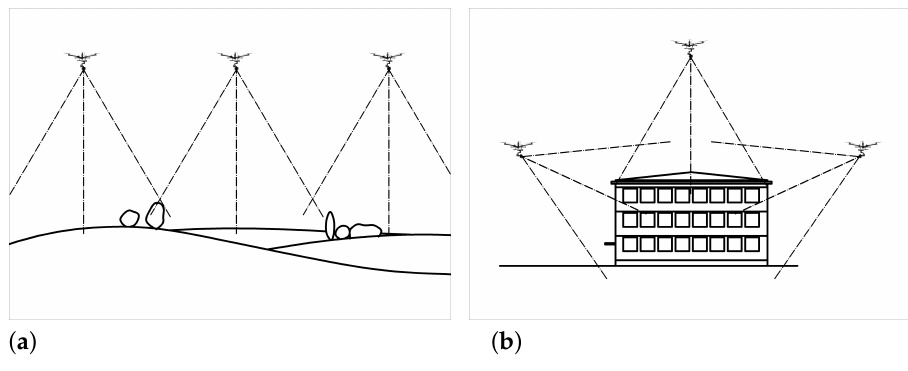
Figure 4. Principles of UAV image acquisition. Orthogonal projection ( a ); oblique projection ( b